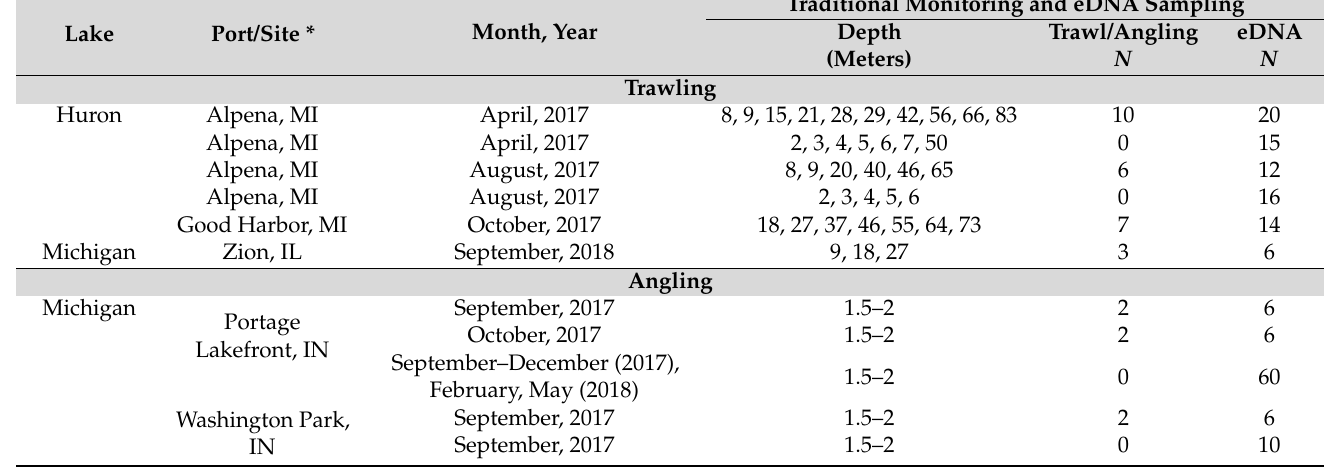
Table 1. Summary of the number of samples ( N ) by traditional monitoring, trawl and angling, and environmental DNA (eDNA) sampling in Lakes Huron and Michigan in 2017–2018. * Exact coordinates for all sampling sites are included in a U.S. Geological Survey data release [24]. Traditional Monitoring and eDNA